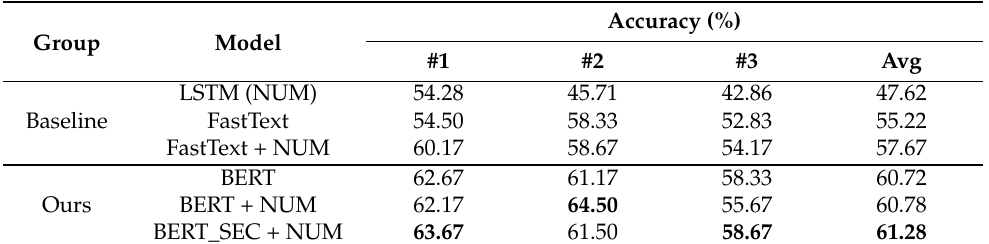
Table 8. Model comparison in terms of “accuracy” on testing data based on a 3 fold-cross validation (#1, #2, #3 refers to the result of each fold), and the boldface represents the winner.